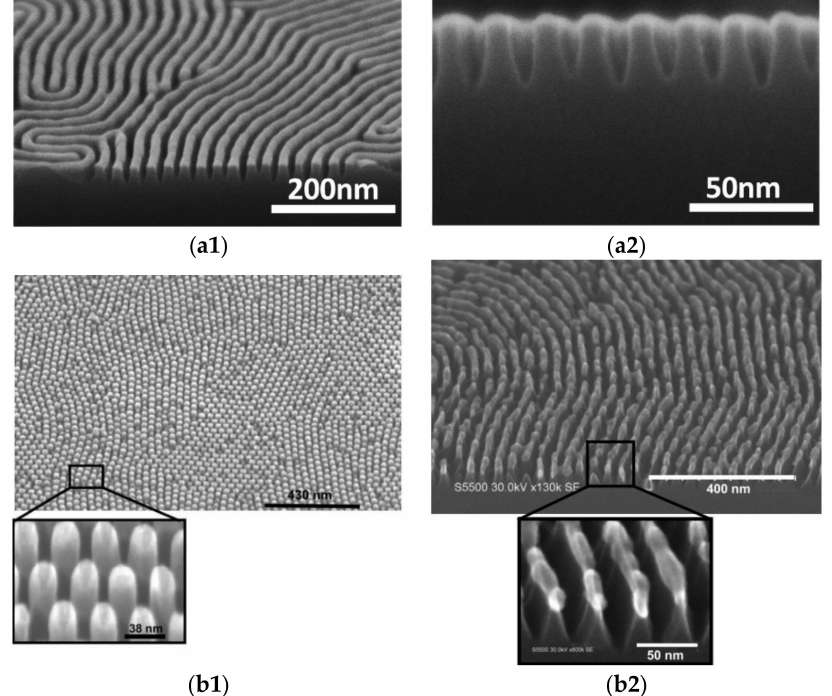
Figure 20. SEM micrographs of patterns produced from a diblock copolymer with PMMA; ( a1 ) cross-section top view ( a2 ) of Si nanowire array with an Al 2 O 3 mask (adapted from [80], Copyright (2015), with permission from Elsevier). Top view, 40 ◦ tilt on top and cross-section of ( b1 ) Al 2 O 3 hexagonally packed nanopillars array treated with plasma and ( b2 ) nanowires made of Si with Al 2 O 3 mask on top (adapted and republished with permission of Guillaume Gay, from [106]; permission conveyed through Copyright Clearance Center,